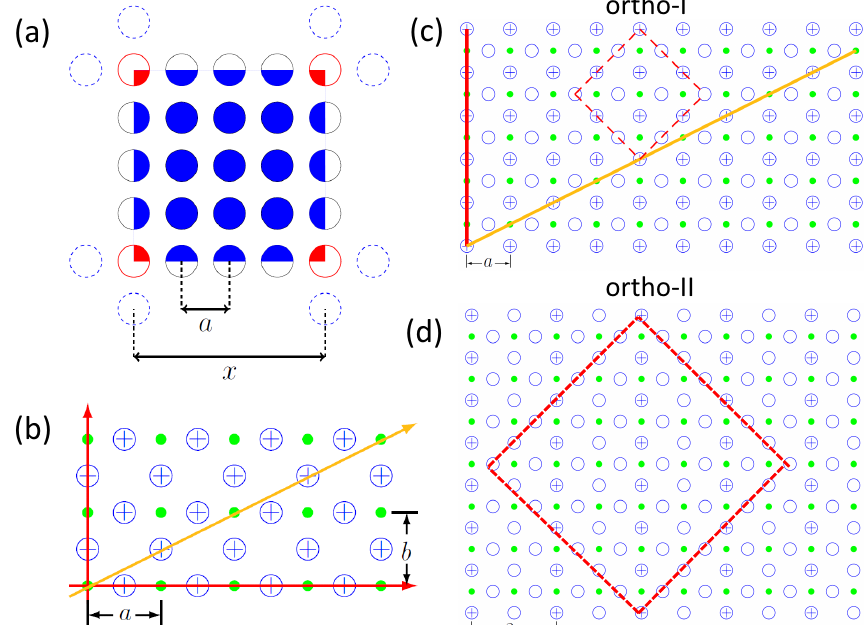
Figure 3. ( a ) Scheme for the determination of the characteristic length, x , for p = 5. The doping elements are indicated as blue, and the matrix elements in red. Each doping element at the corners of this cell are counting with only 1/4, and the other edge elements with 1/2. a is the distance between two matrix elements as indicated. ( b ) Schematic drawing of the Cu-O-plane following Ref. [9] with a = b . The oxygen atoms are drawn using (cid:76) and the Cu atoms as • . The two Cu-O-Cu-O-chains identified there are indicated as red ( ) and orange ( ) vectors. a and b are the crystallographic axes of YBCO. Images ( c , d ) show the ortho-I ( c ) and ortho-II ( d ) structures redrawn from Poulsen et al. and Andersen et al. [35,36]. Oxygen vacancies are indicated using open blue circles ( (cid:13) ). Note the periodicity of 2 a in ( d ). The red-dashed squares indicate the MSCs of the ortho-I and ortho-II phases. The orange and red lines identified by Roeser et al. [9] can be located here as well, as indicated in ( c ).